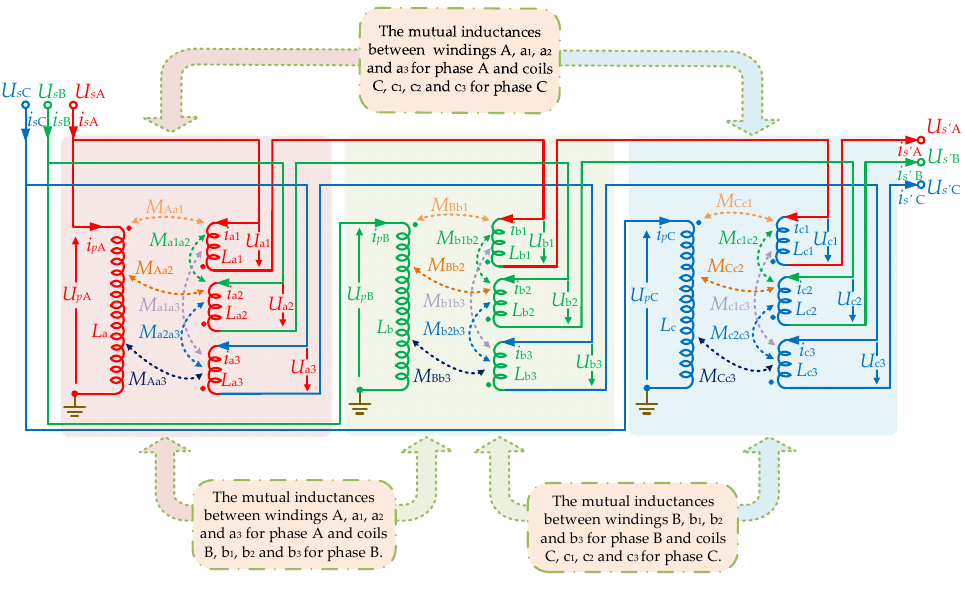
Figure 2. The coupled circuit of the ST.